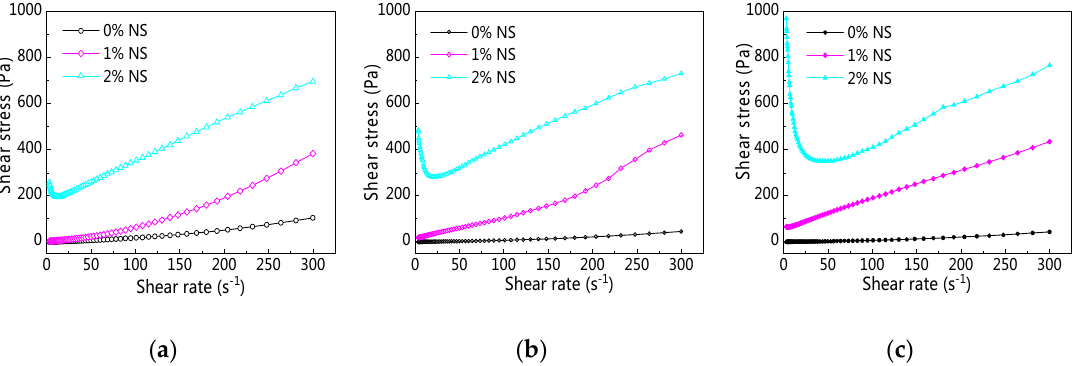
Figure 6. Rheological curve of cement–fly ash (C–FA) paste with nano-SiO 2 (NS). ( a ) 5 min; ( b ) 60 min; ( c ) 120 min.